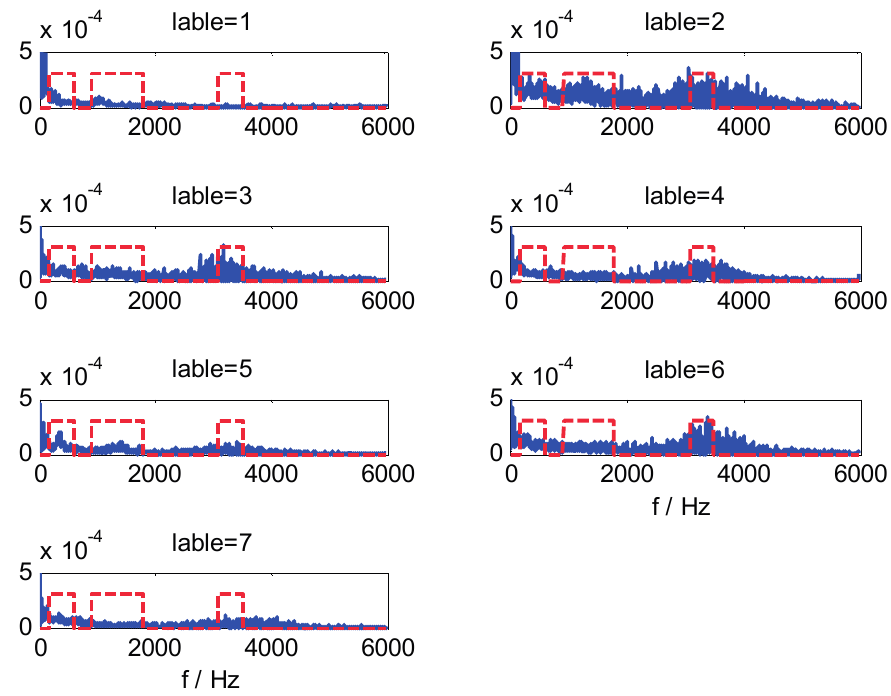
Figure 10. The extracted HMS-CFBs of samples in different kinds of fault types for SNR =